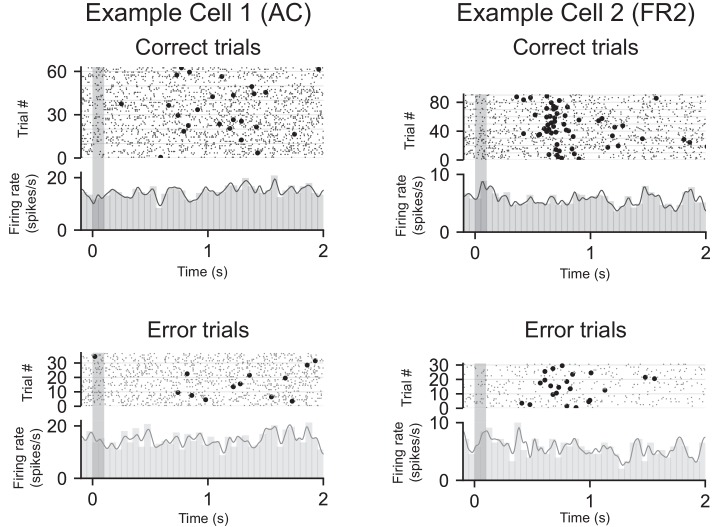
PSTHs from two example cells recorded in either AC or FR2 separated by correct (top) and error (bottom) trials.All PSTHs are stimulus-aligned. The grey bar indicates stimulus presentation and circles represent behavioral response.